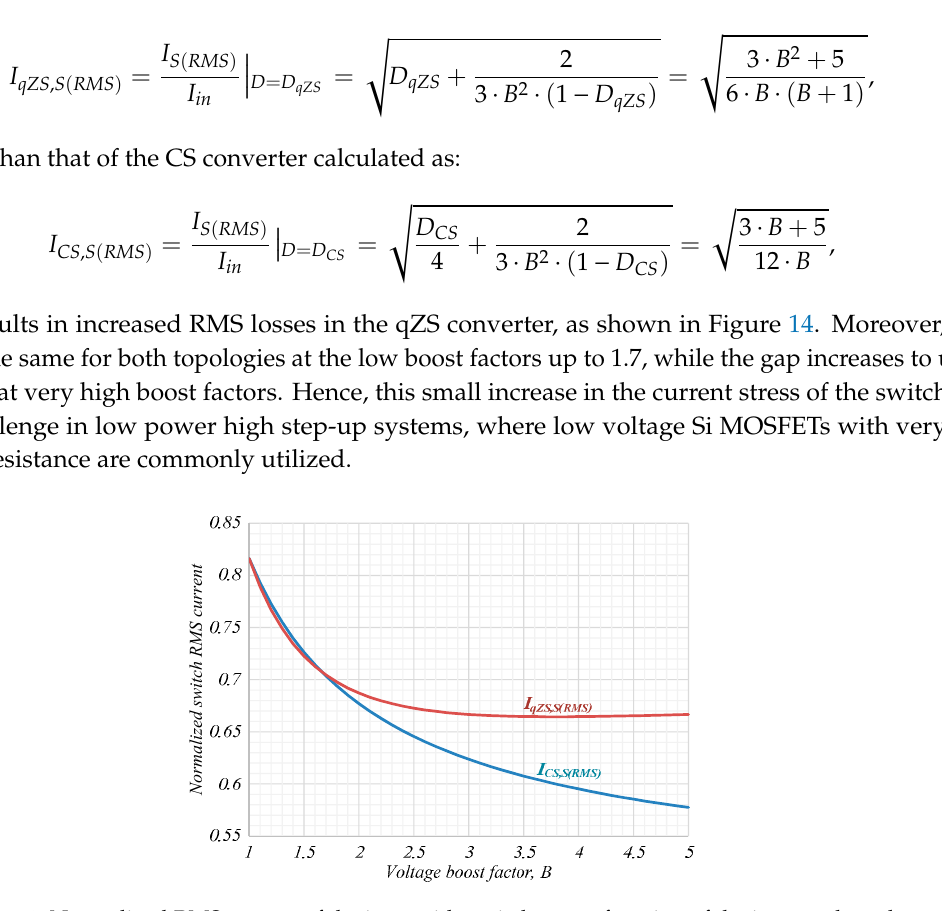
Figure 14. Normalized RMS current of the input side switches as a function of the input voltage boost factor B .